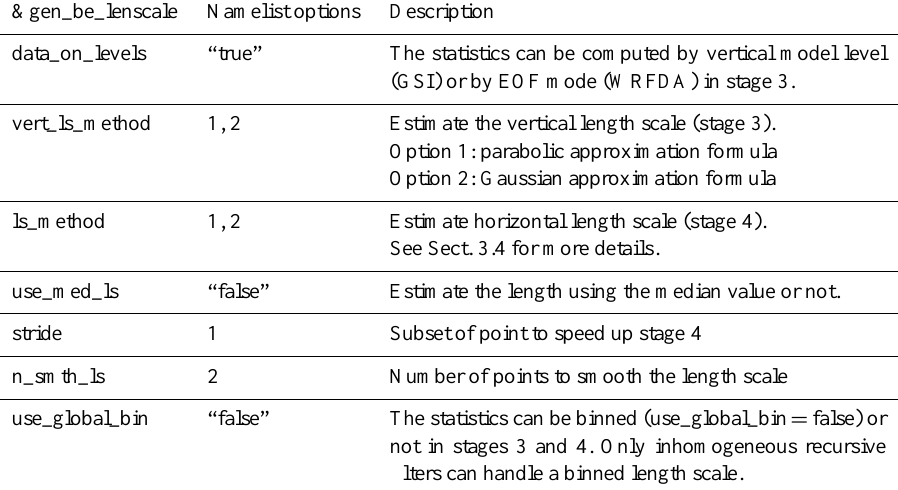
Table B6. Description of the options available in the namelist input file (&gen_be_lenscale part) to diagnose the length scale